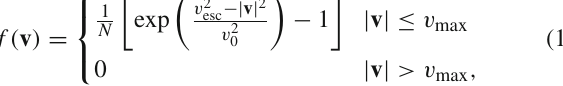
DMO). The solid lines represents exclusion limit when SHM is fitted to thesimulationswhichincludesbothbaryonandDM(denotedbyDMB). The orange and red lines represent the APOSTLE and ARTEMIS sim- ulations. The other relevant details are mentioned in Fig.